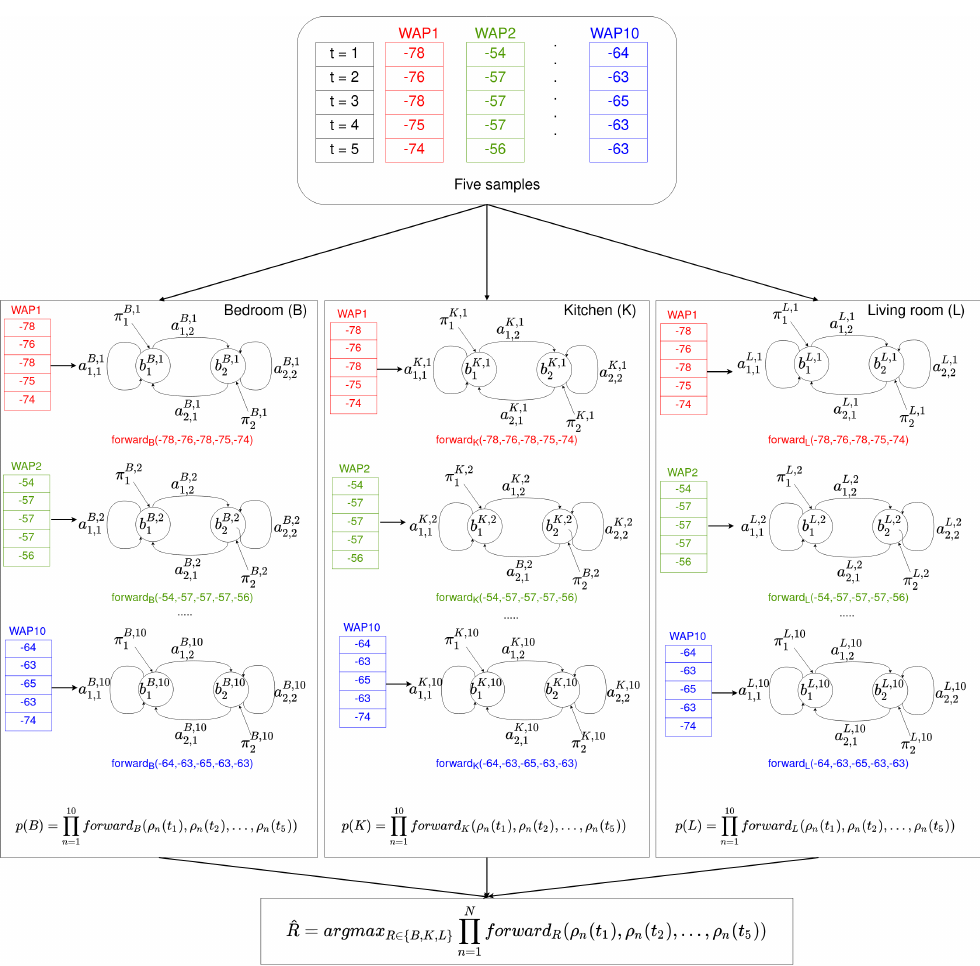
Figure 6. An example of the offline phase. For each room (bedroom, kitchen, and living room) and for each time series received from a WAP present in the environment (10 in this example), an HMM was built. Note that for each sequence of 5 samples arriving from a WAP (same color), each of the 10 HMMs provides a probability using the forward algorithm. The probability of being at rooms {bedroom, kitchen, living room} is evaluated as the product of the 10 previous probabilities. Finally, the estimated room ˆ R is such that it provides the maximum